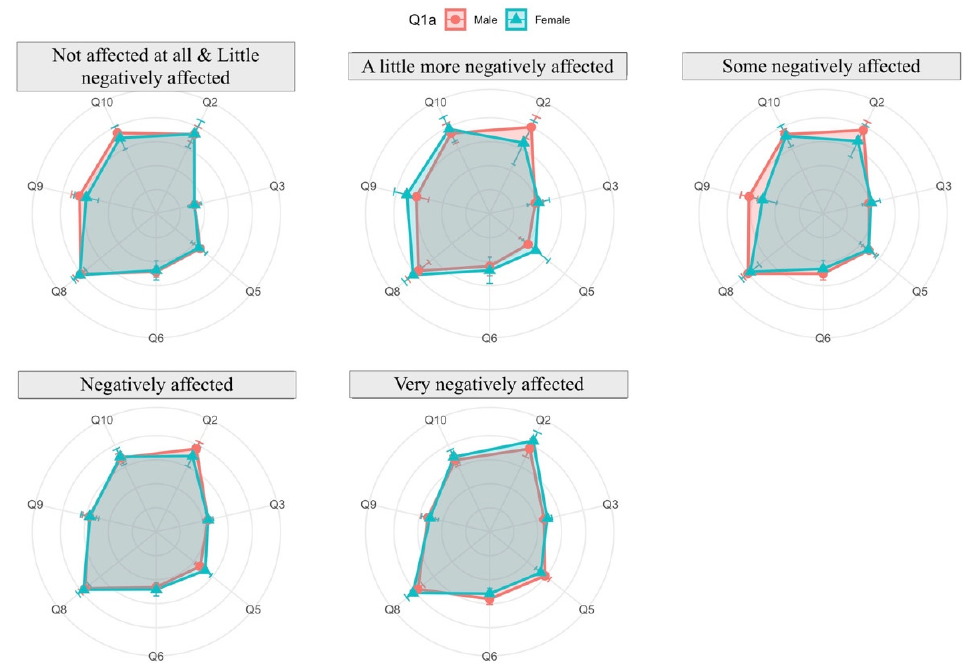
Figure 20. Effects on research due to virtual teaching dedication (answers to Q11) related to other aspects and disaggregated by gender.